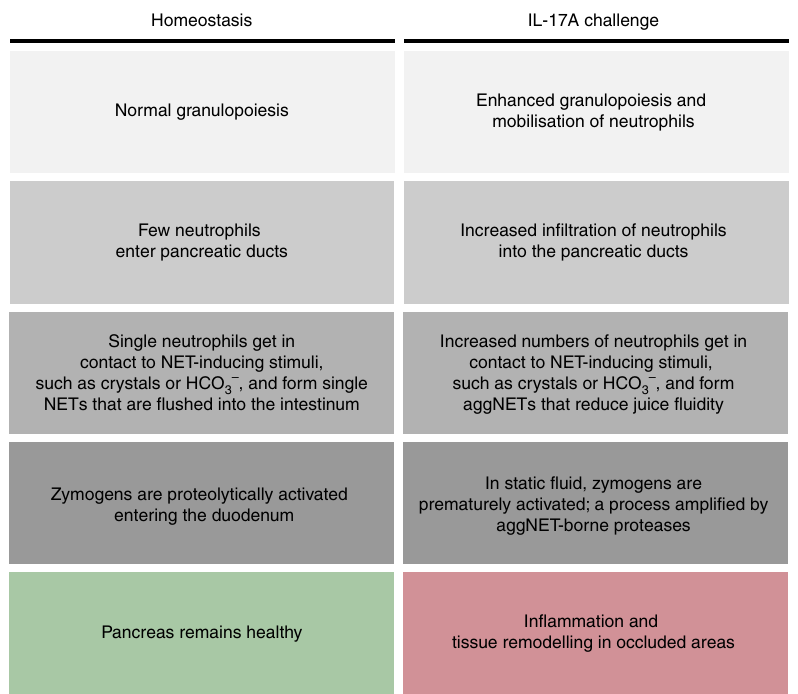
Figure 7 | Hypothesis chart. Danger signals, exemplified by IL-17A challenge, instigate enforced granulopoesis, neutrophil mobilization and increased chemoattraction to the pancreas. When neutrophils encounter stimuli in the pancreatic juice such as elevated bicarbonate levels or CaCO 3 precipitations, they form aggNETs. The large chromatin tangles of the latter reduce the fluidity of the pancreatic juice and consequently hamper secretory flow and lead to focal occlusion of the ductal tree. In occluded areas, digestive zymogens undergo premature activation. AggNET-borne serine proteases in static fluid may amplify this process. Dependent acini are destroyed, inflammation is perpetuated and finally tissue remodelling